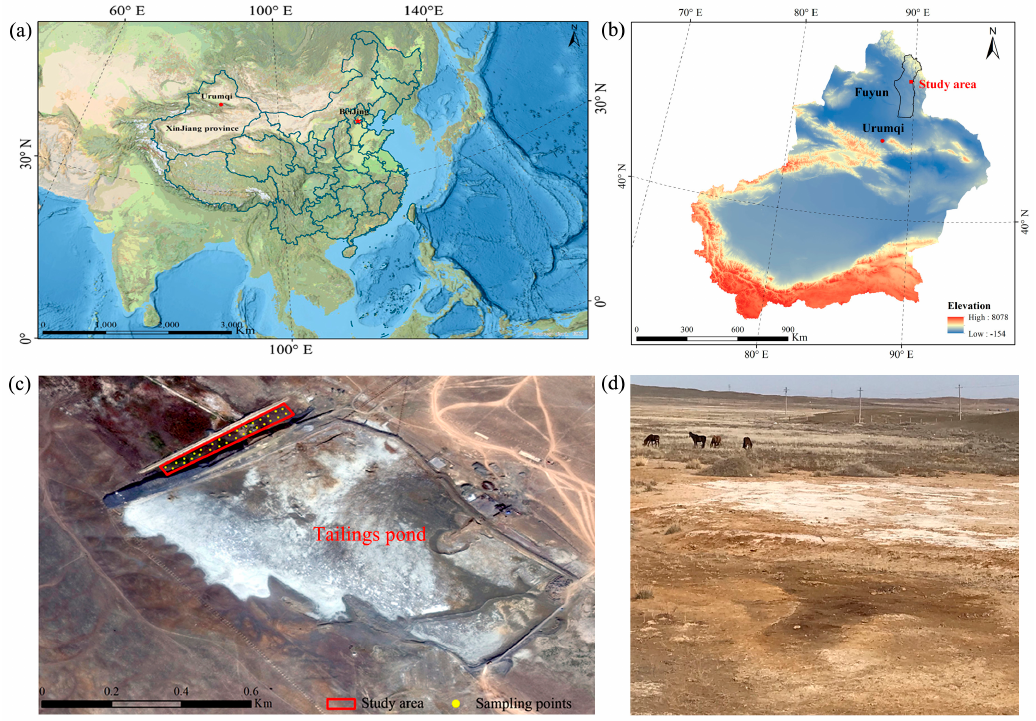
Figure 1. Study area and sampling points: ( a ) The location of Xinjiang in China; ( b ) The location of Fuyun County in Xinjiang; ( c ) Distribution of sampling points; ( d ) Pictures of the contaminated area. (The map is based on the standard map number GS (2016) 1666 downloaded from the standard map service website of the National Bureau of Mapping Geographic Information, and the base map is not modified. https://earthexplorer.usgs.gov/, accessed on 15 November).